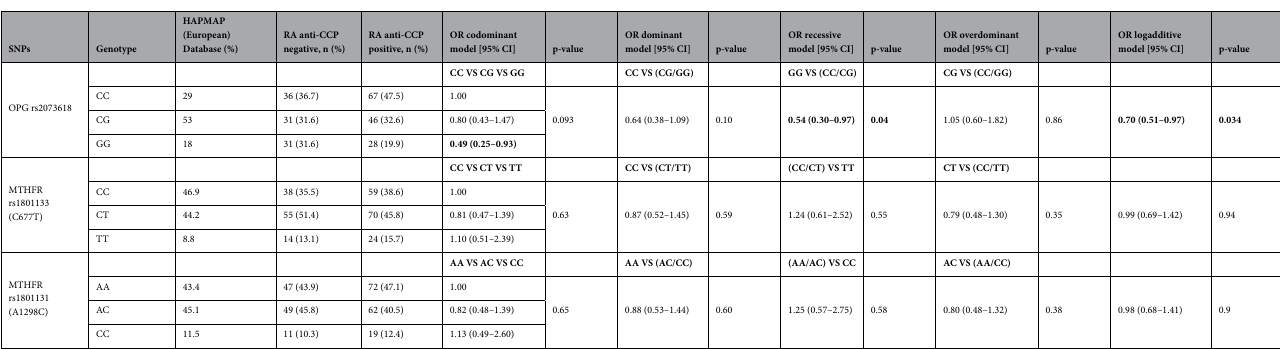
Table 6. Prevalence of the OPG rs2073618 and the MTHFR rs1801133 and rs1801131 SNP genotypes in RA anti-CCP negative and anti-CCP positive patients, adjusted by gender and age. Genotypes, OR and p-value for the five genetic models (codominant, dominant, recessive, overdominant and additive) were estimated with SNPstats software (statistically significant if p < 0.05). OPG osteoprotegerin, MTHFR methylene tetrahydrofolate reductase, OR odds ratio, SNP single nucleotide polymorphism, VS versus, RA rheumatoid arthritis, anti-CCP anti-cyclic citrullinated peptide, HAPMAP haplotype map. Significant values are in